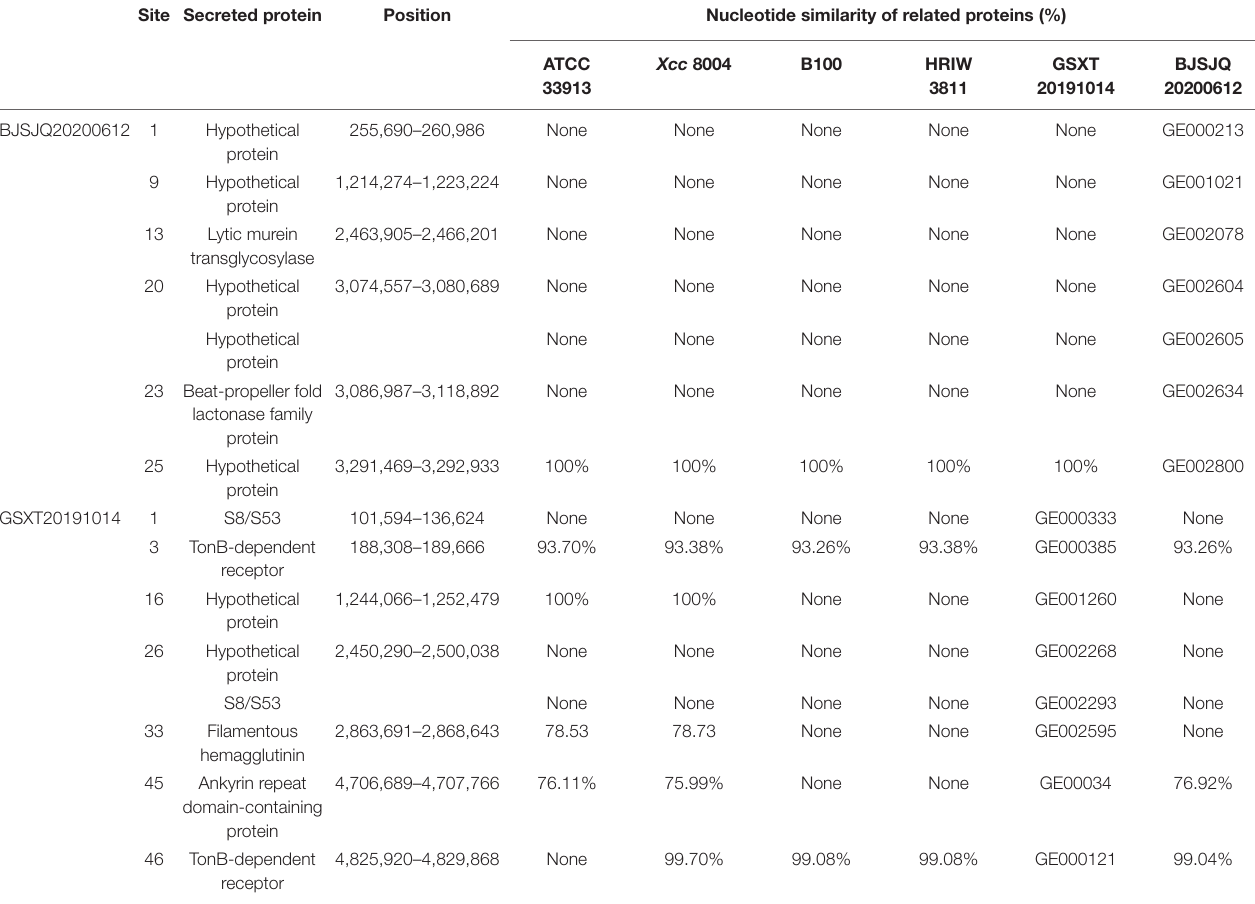
TABLE 3 | The secreted proteins in the variable genomic regions of BJSJQ20200612 and GSXT20191014 genomes. Site Secreted protein Position Nucleotide similarity of related proteins